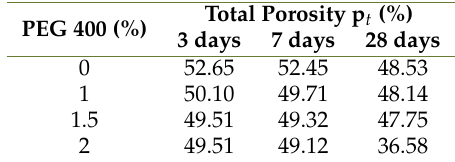
Fig. 9. Total Porosity Values at 0.55 Water-Cement Ratio. Fig. 8. Capillary Porosity Values at 0.55 Water-Cement Ratio. Table 9. Gel/Space Ratio at 0.34 Water-Cement Ratio. Table 8. Total Porosity at 0.55 Water-Cement Ratio. PEG Gel/